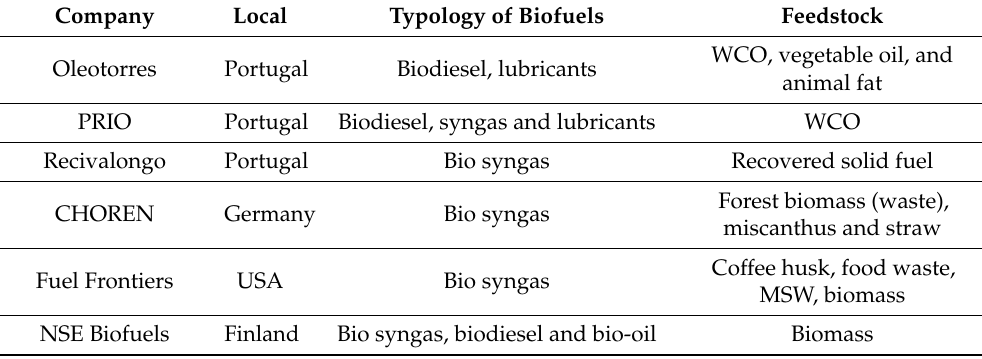
Table 4. Companies that use gasification to produce biofuels.